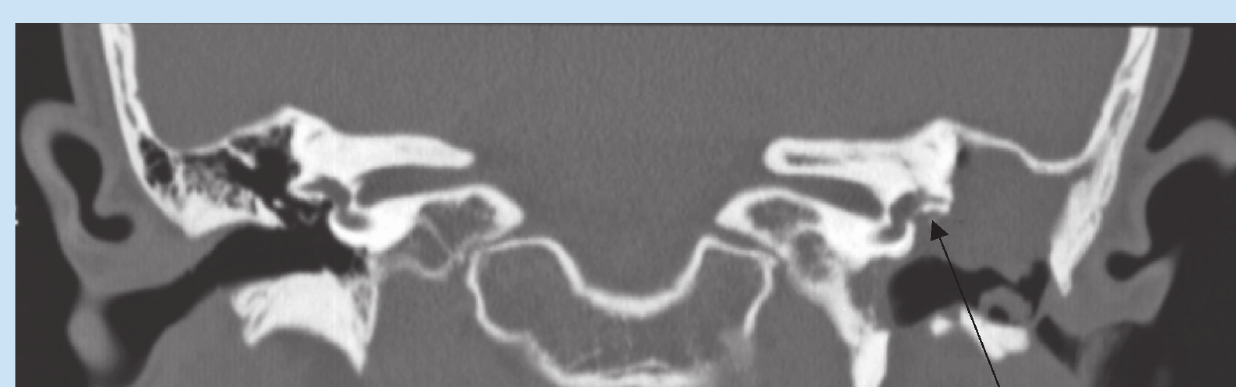
Fig. 3. Coronal CT displaying erosions adjacent to the vestibule (arrow).